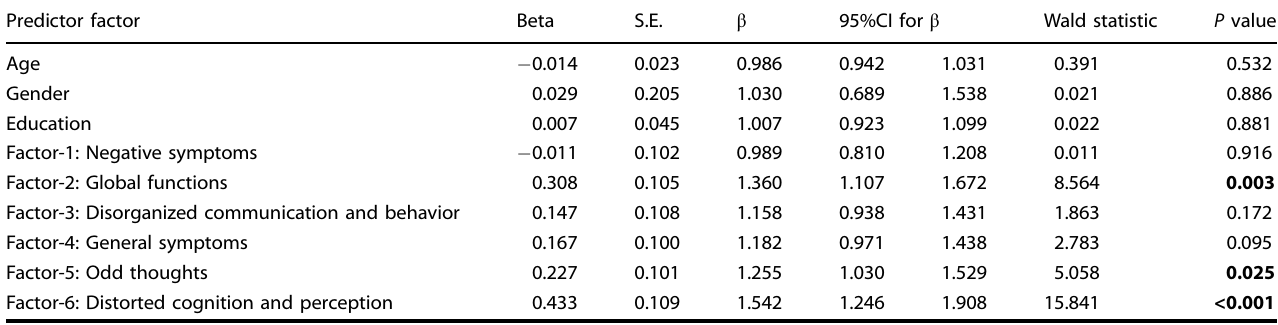
Table 4. Logistic regression for predicting the CHR individuals ’ decision of antipsychotics assumption on demographic and factorial variables ( n = 532).